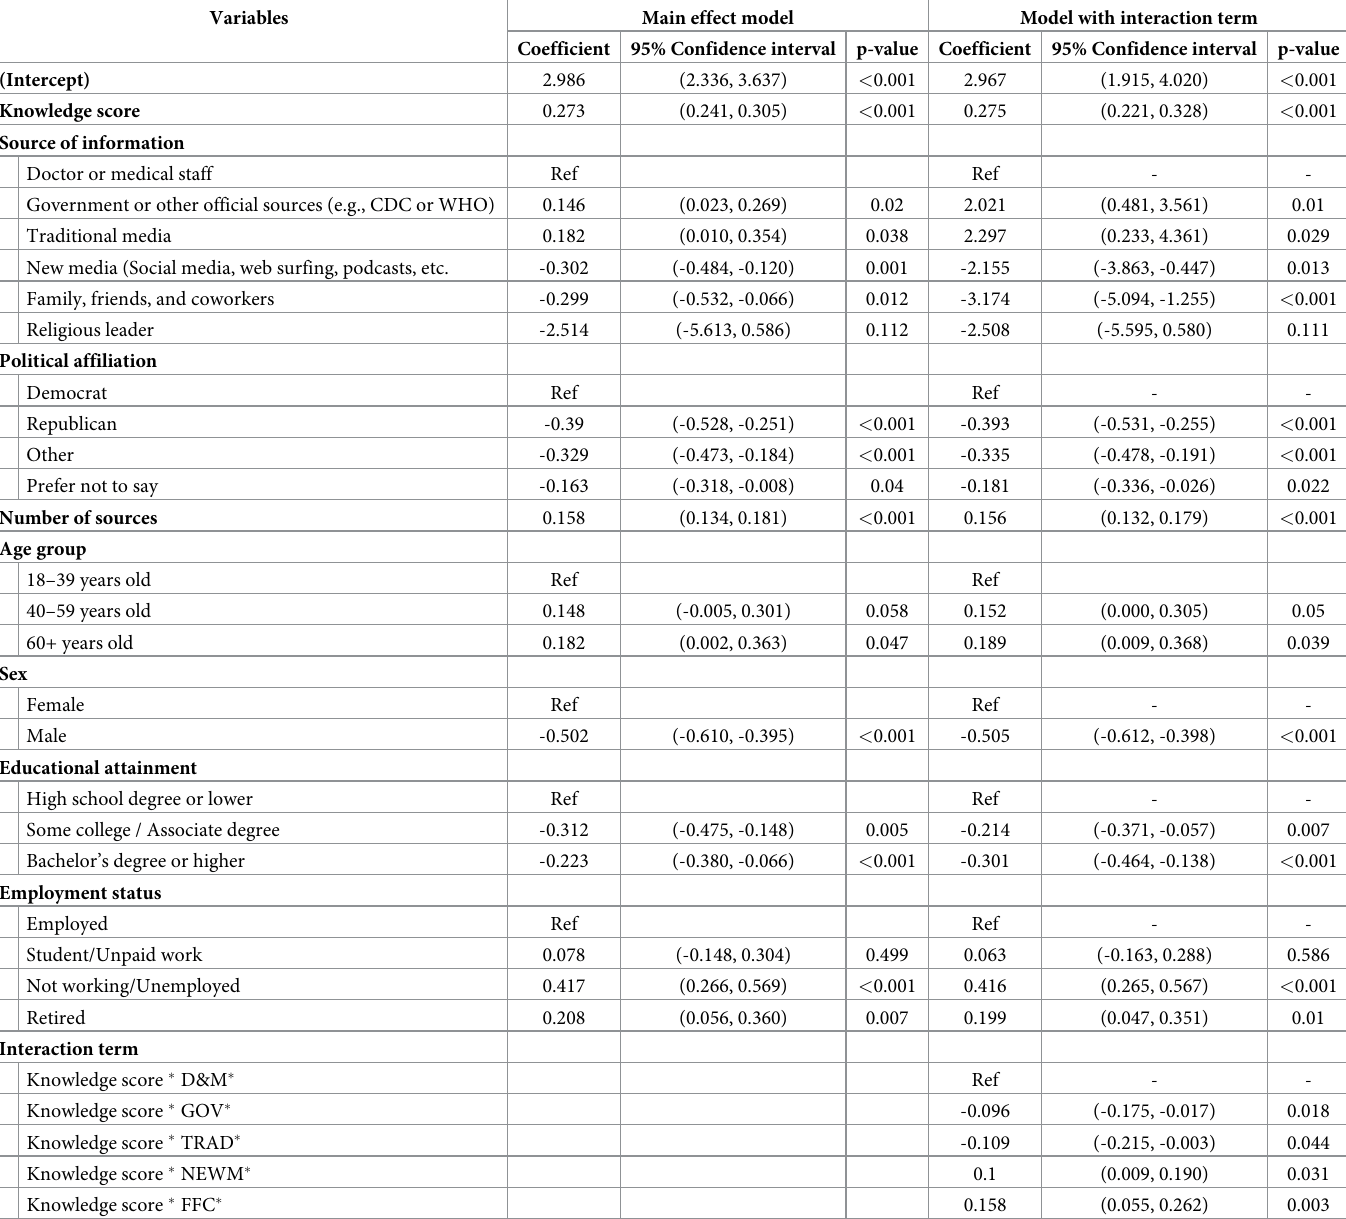
Table 2. Main effect model and the full linear regression model between the COVID-19 knowledge score and the protective behavior score with covariates and the interaction term (n =